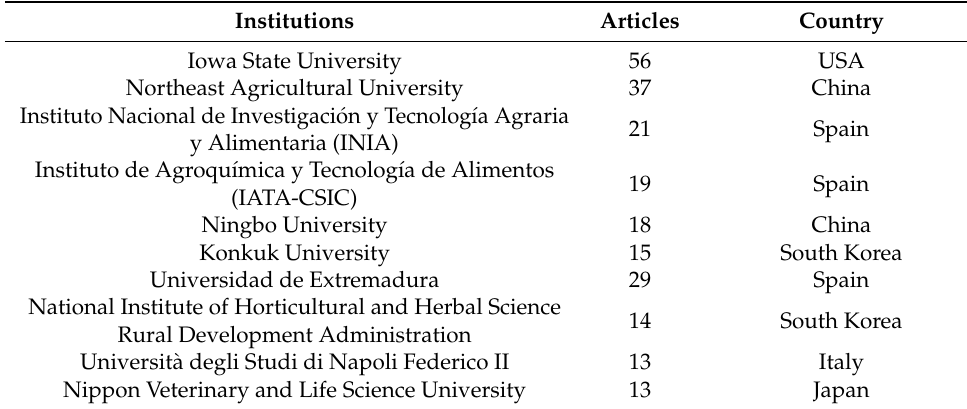
Table 5. The 10 most productive institutions in the field of meat VOC profiles and the numbers of articles